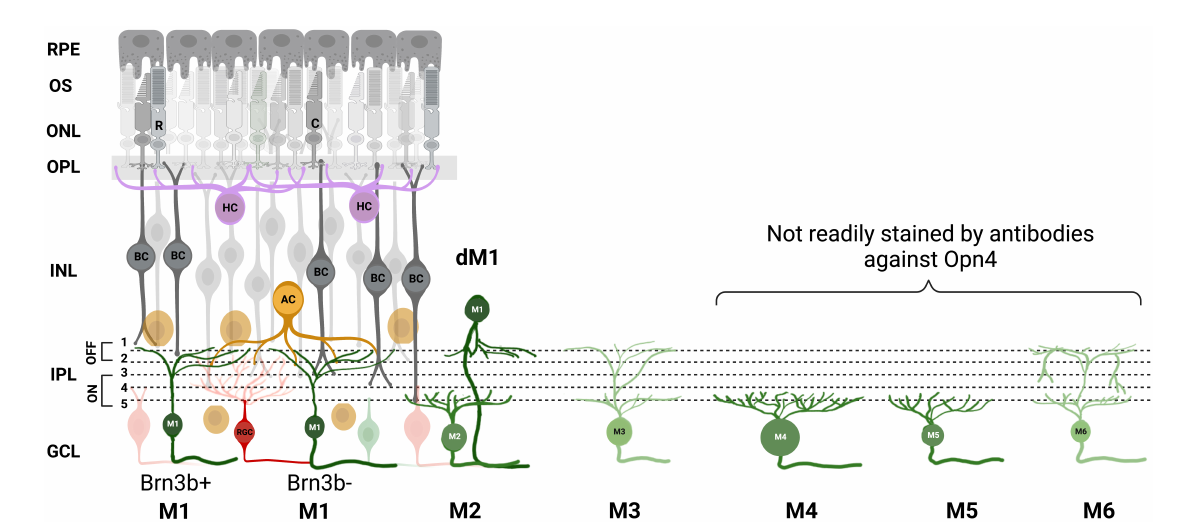
FIGURE1 ipRGC subtypes. A, Schematic of the mouse retina with the 6 melanopsin subtypes and their stratification in the inner plexiform layer (IPL) depicted. M1 ipRGC subtype is further divided into Brn3b positive and negative, and displaced M1s (dM1). Retinal pigment epithelium (RPE), outer segment (OS), outer nuclear layer (ONL), outer plexiform layer (OPL), inner nuclear layer (INL), ganglion cell layer (GCL), rods (R), cones (C), bipolar cell (BC), amacrine cell (AC), horizontal cell (HC). Image was created with